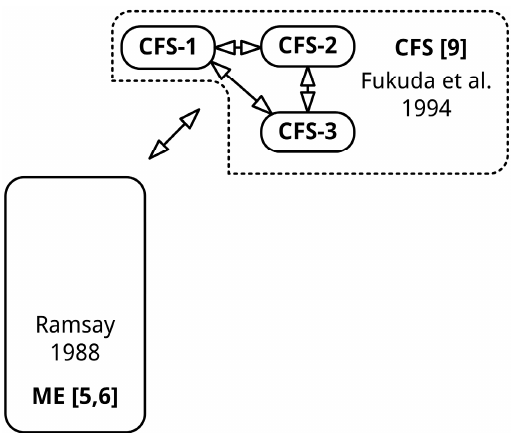
Figure 4. Proposed solution to resolve the diagnostic impasse. The sizes of the shapes do not reflect the absolute sizes of various patient (sub)populations.